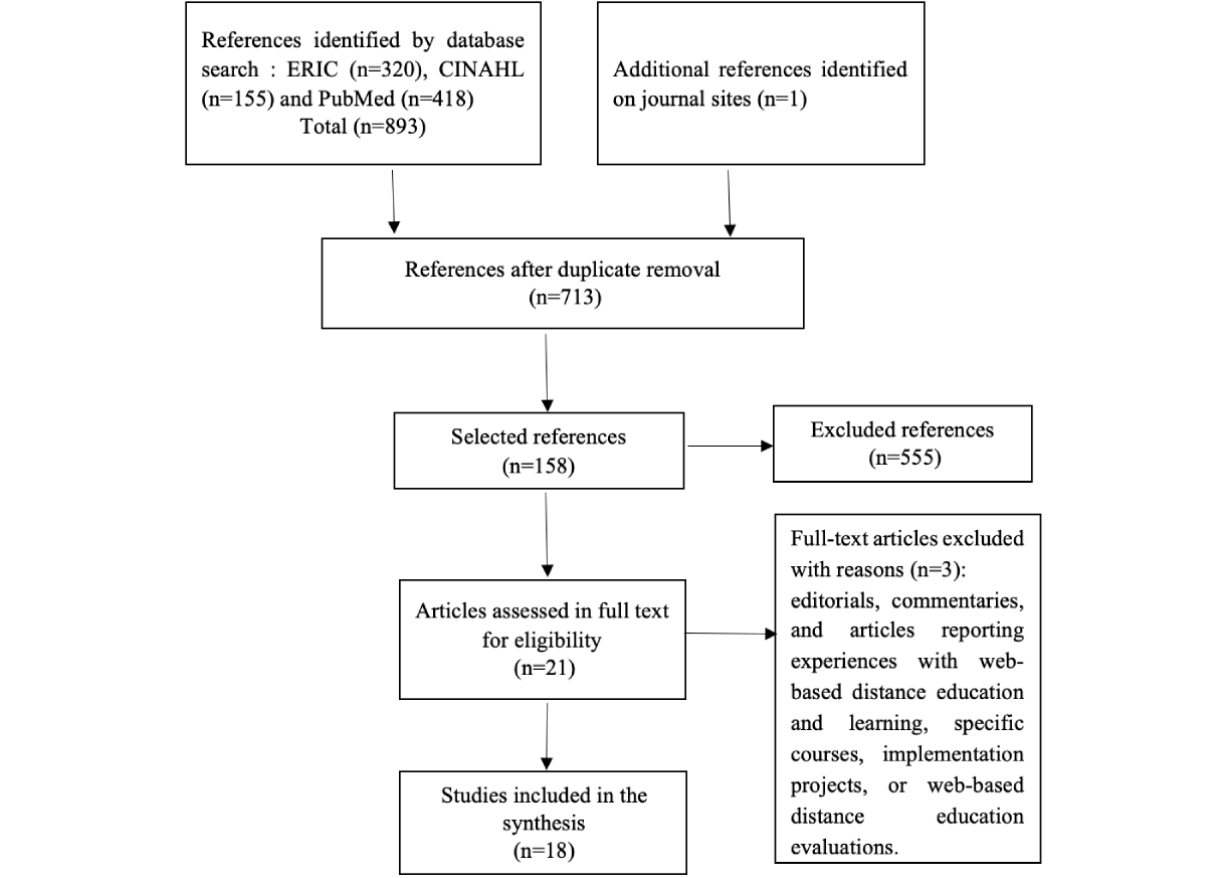
Figure 2. Adapted PRISMA (Preferred Reporting Items for Systematic Review and Meta-Analysis Protocols) flow diagram to show the results of the searches in the second literature